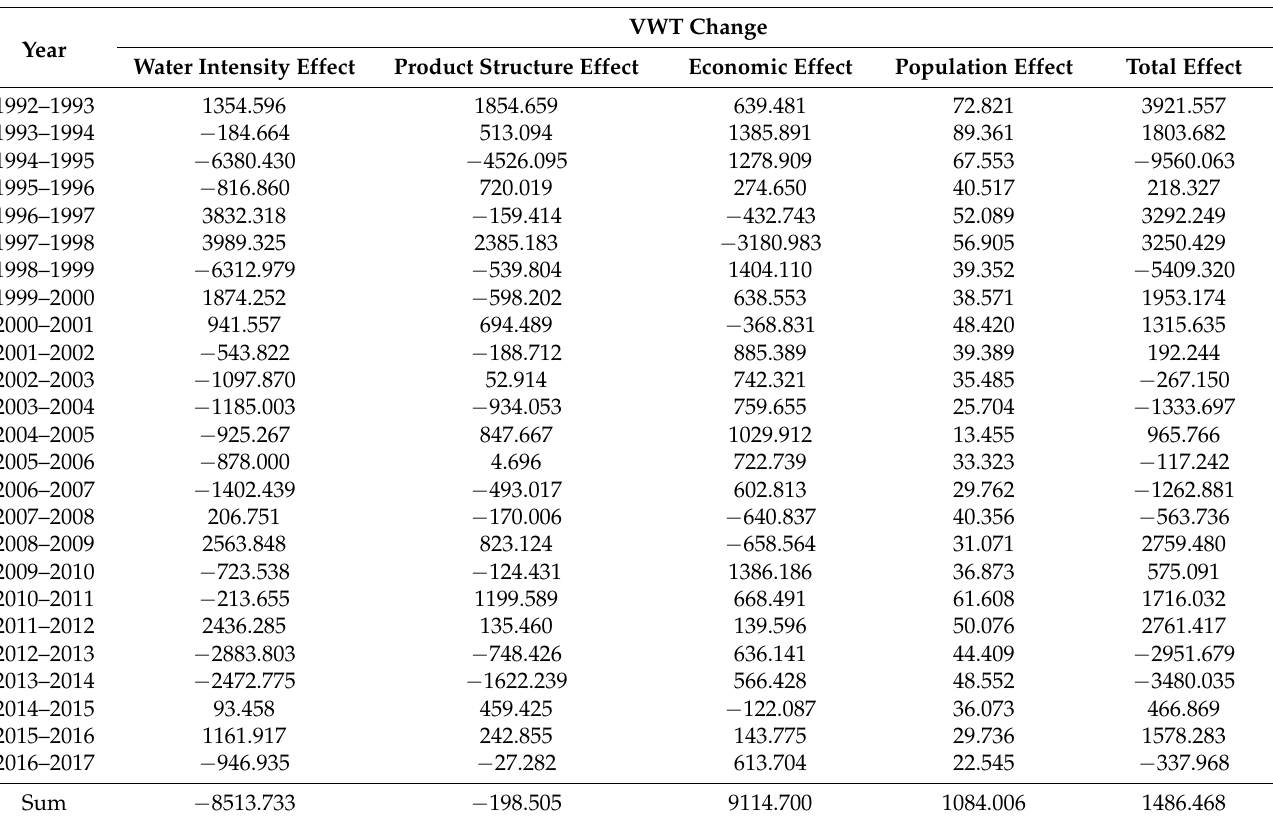
Table A5. The logarithmic mean divisia index (LMDI) analysis of wheat virtual water trade (VWT) change in South Korea (million m 3 ).